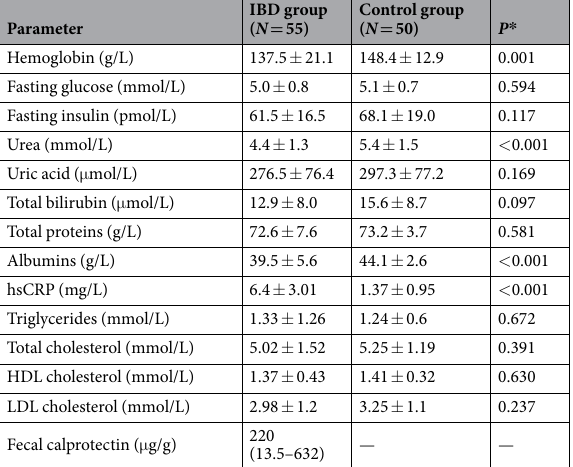
— — Table 2. Laboratory parameters of IBD patients and healthy controls. Abbreviations: hsCRP- high sensitivity C-reactive protein. Data are presented as mean ± standard deviation or median (IQR). * t-test for independent